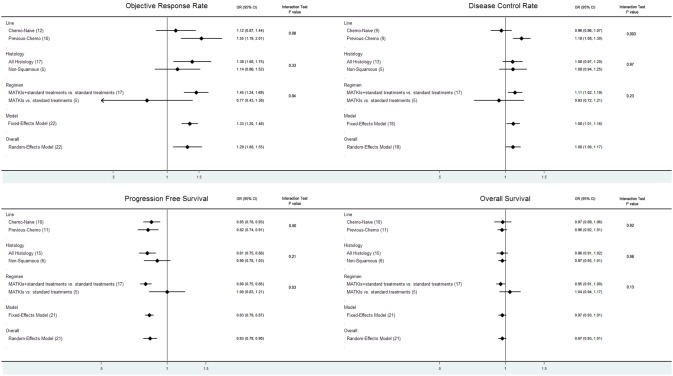
Subgroup analyses of each endpoint (number of studies or arms).A, ORR; B, DCR; C, PFS; D, OS.